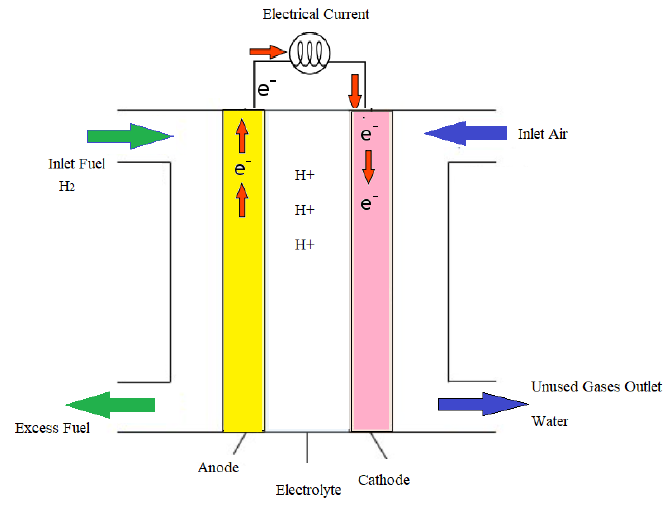
Figure 1. Schematic diagram of a fuel cell working